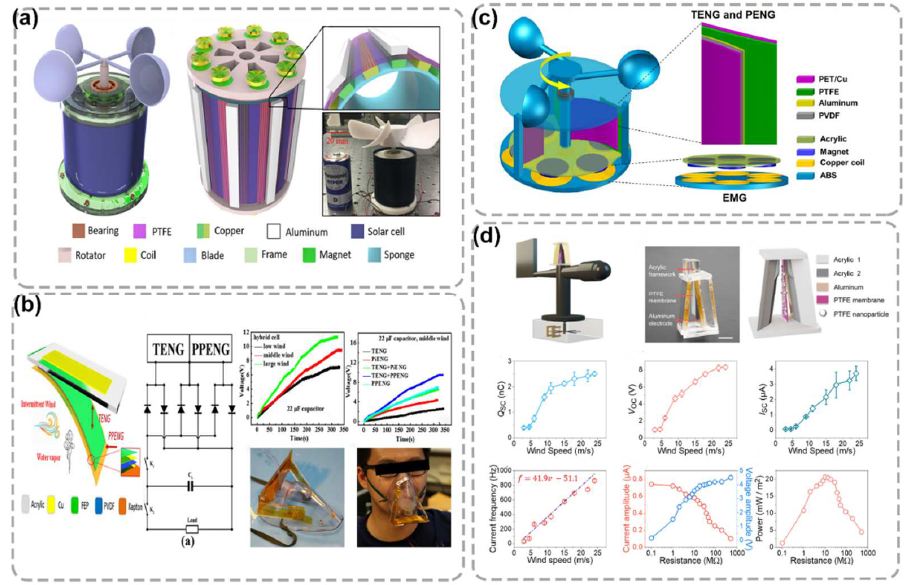
Figure 7. WD-TENG hybridized with other generators. ( a ) Hybrid TENGs combined with EMG and TENG. Reproduced with permission of [30], Copyright 2018, Elsevier. ( b ) Hybrid TENGs combined with PPENG and TENG. Reproduced with permission of [76], Copyright 2018, American Chemical Society. ( c ) Hybrid TENGs combined with PENG and TENG. Reproduced with permission of [77], Copyright 2018, Elsevier. ( d ) WD-TENG combined with photoelectric technology. Reproduced with permission of [78], Copyright 2021,